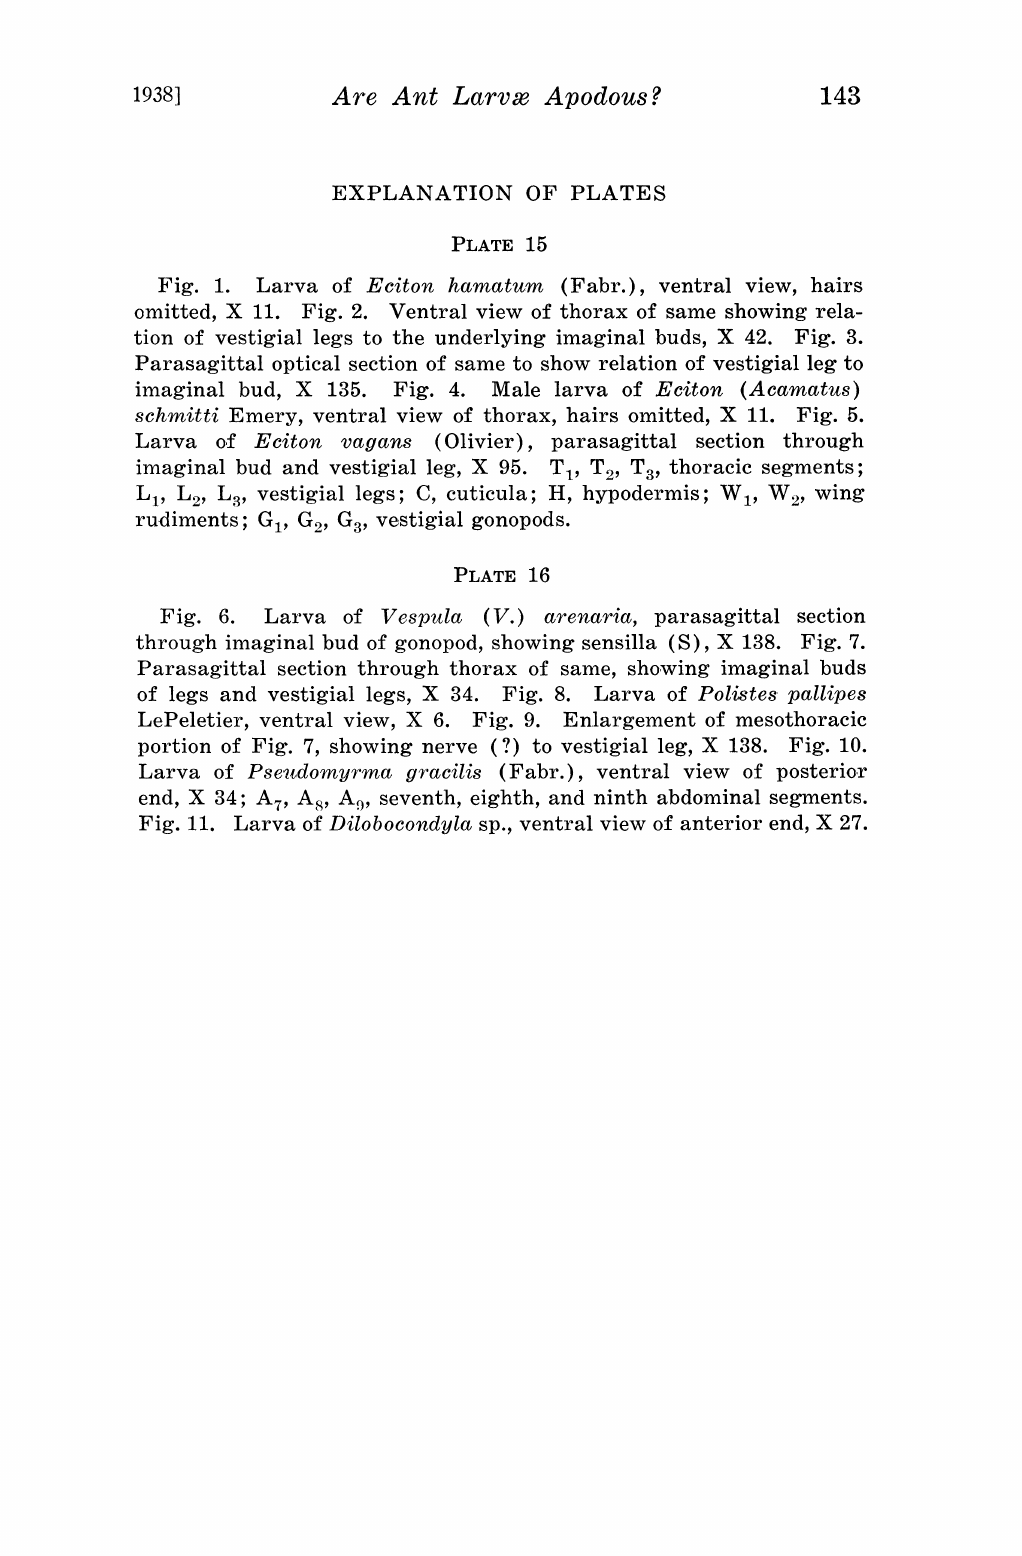
Fig. 1. Larva of Eciton hamatum (Fabr.), ventral view, hairs omitted, X 11. Fig. 2. Ventral view of thorax of same showing rela- tion of vestigial legs to the underlying imaginal buds, X 42. Fig. 3. Parasagittal optical section of same to show relation of vestigial leg to imaginal bud, X 135. Fig. 4. Male larva of Eciton (Acamatus) schnitti Emery, ventral view of thorax, hairs omitted, X 11. Fig. 5. Larva o.f Eciton vagans (Olivier), parasagittal section through imaginal bud and vestigial leg, X 95. TI, T2, T3, thoracic segments; L C, cuticula; H, hypodermis; W1, W L L wing a, vestigial legs; 2, 1, 2, rudiments; G1, G2, Ga, vestigial gonopods.